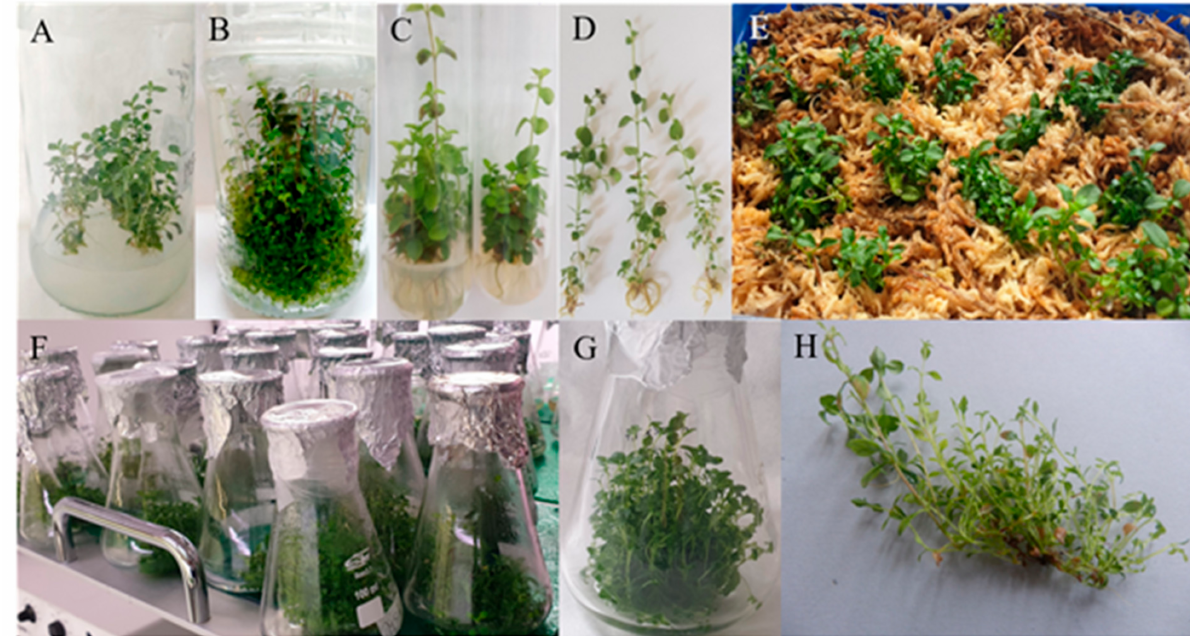
Figure 1. Micropropagation of Linnaea borealis var. borealis ( A ) shoots on the solidified medium; ( B ) multiplied shoots on the solidified medium; ( C ) rooted shoots; ( D ) rooted shoots before acclimatization; ( E ) micropropagated plantlets hardened in a glasshouse; ( F ) micro-shoots in the liquid media on a rotary shaker; ( G ) multiplied shoots in the liquid medium obtained from double shoots; ( H ) multiplied shoot obtained from one shoot explant from the liquid